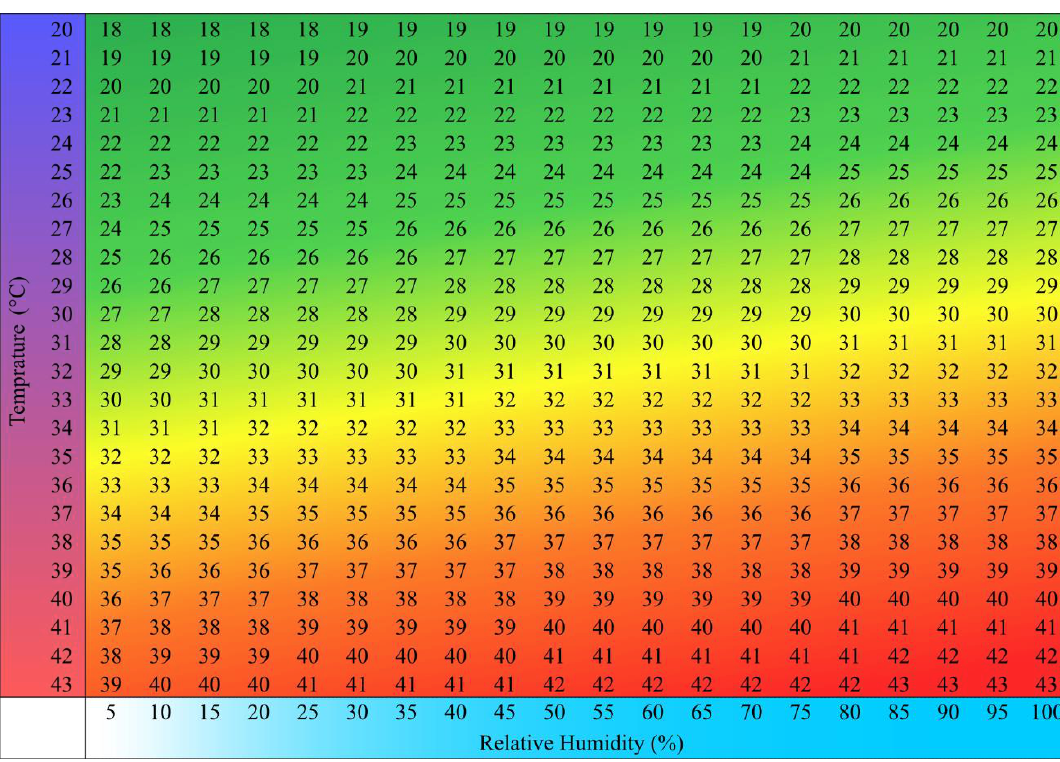
Figure 11. The numerical values of THI corresponding to various temperature and relative humidity levels. The green color presents relatively better THI whereas a red color reflects the worst scenario of THI.